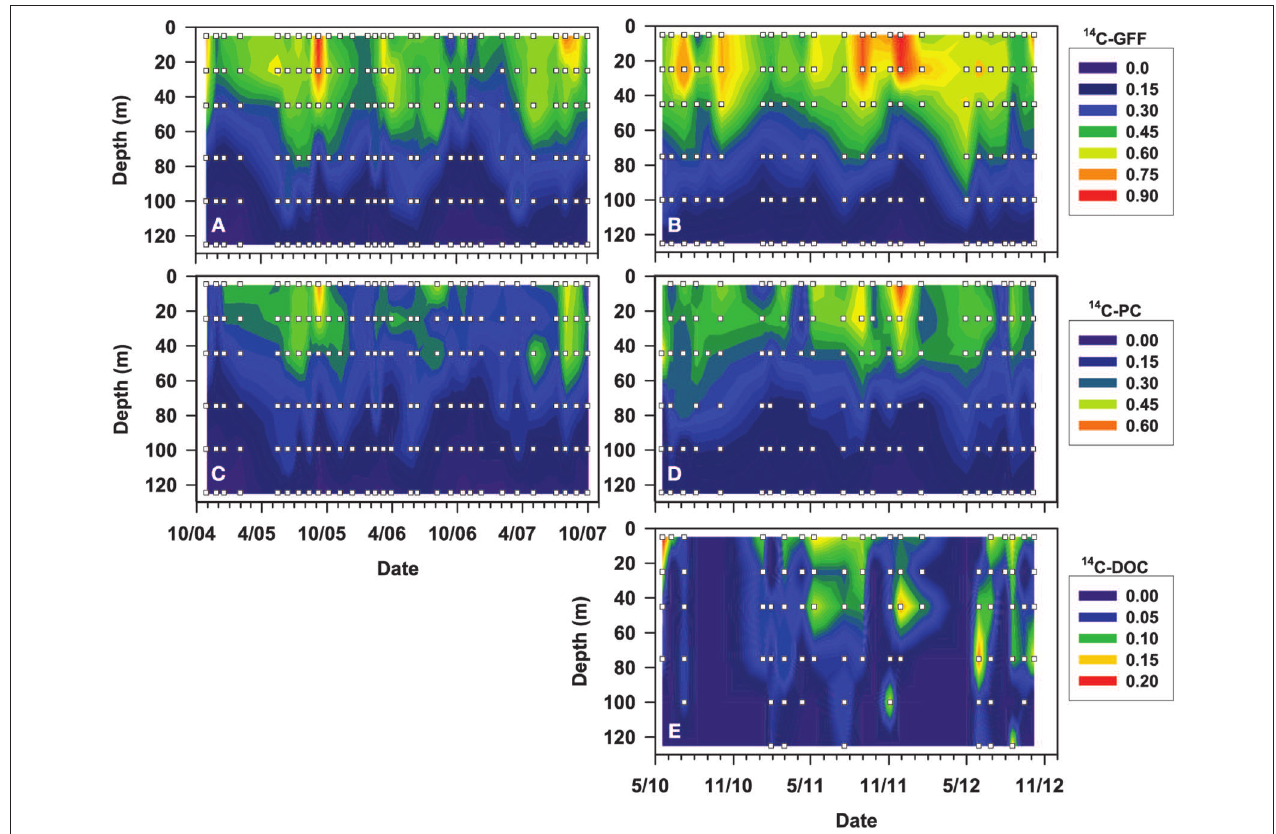
FIGURE 3 | Contour plots depicting vertical distributions of rates of 14 C-GFF (A,B), 14 C-PC (C,D), and 14 C-DOC (E), in µ mol C L − 1 d − 1 , over the time periods (October 2004–October 2007 and April 2010–October 2012) evaluated for this study. White squares depict depths and dates where detectable rates were